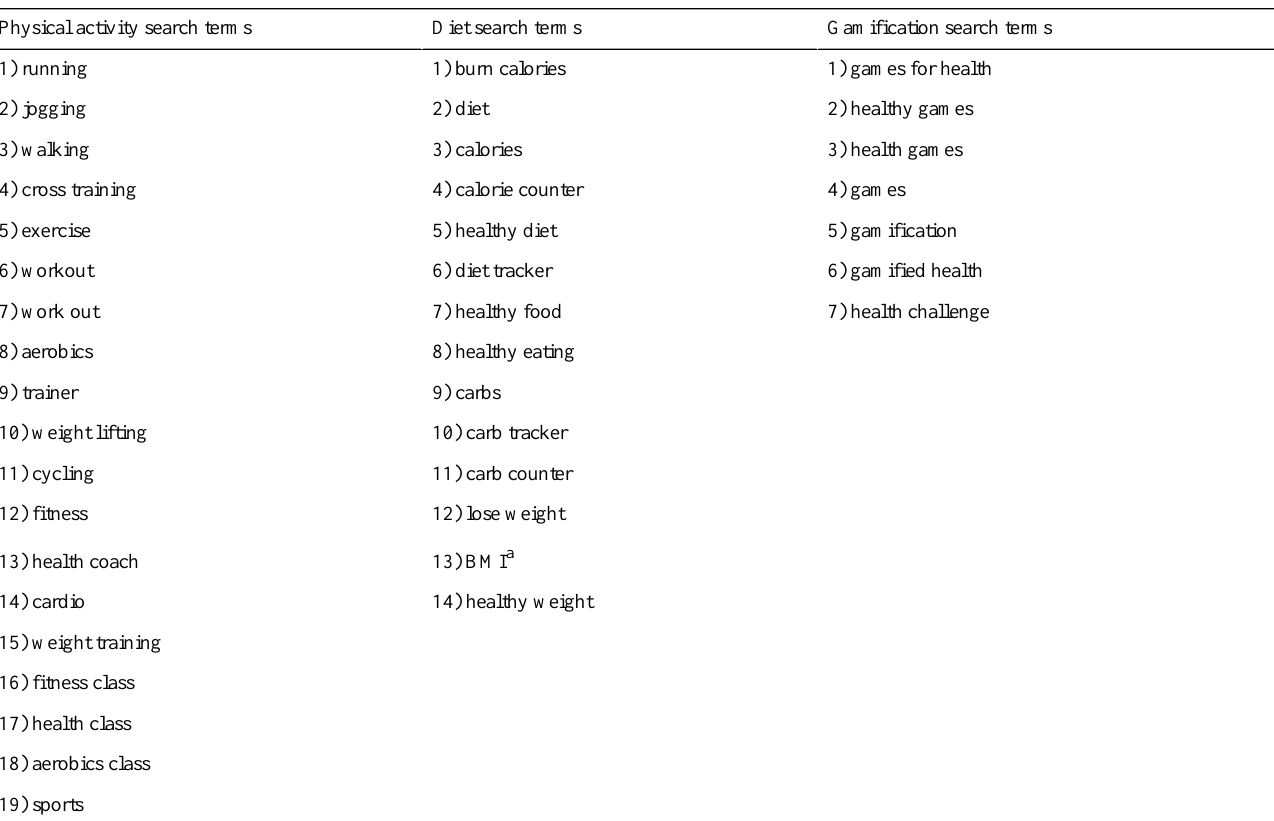
Table 1. Apple App Store search